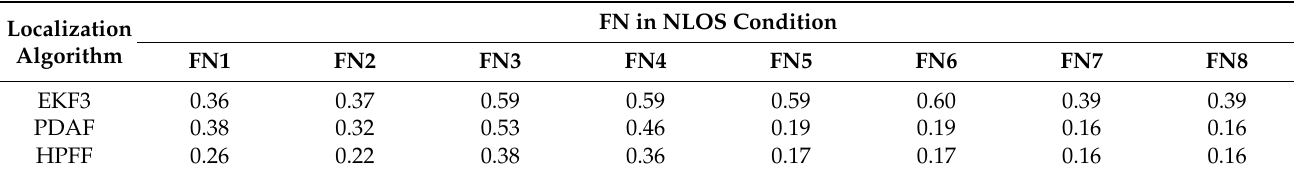
Table 2. RTAMS position errors (unit: meter) in constant NLOS conditions.